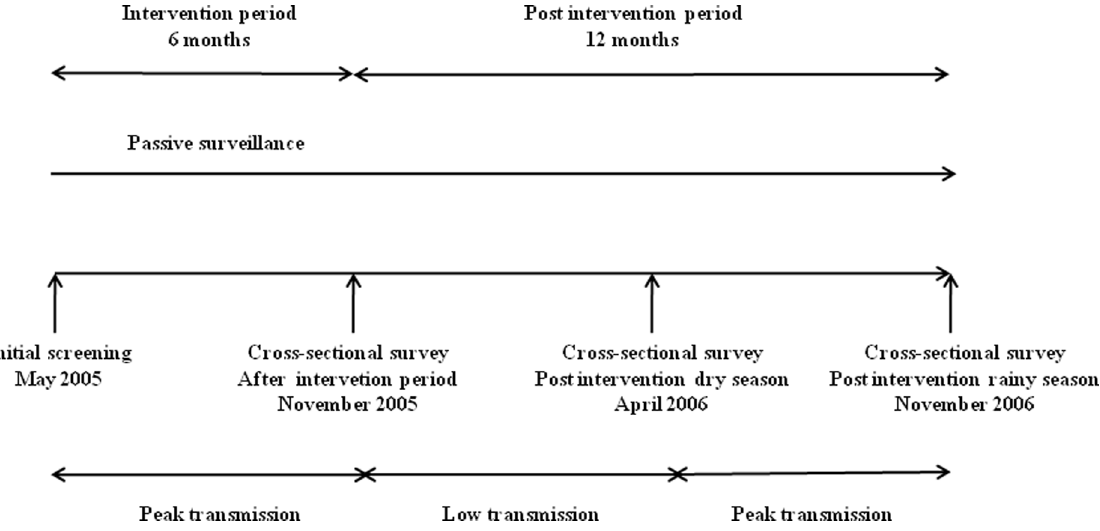
Figure 1. Study outline. Intermittent preventive treatment or placebo was given over a six month-period spanning peak malaria transmission season, followed by a 12-month post interventionsurveillance period. Cross-sectional surveys were performed 1 month (November 2005), 6 months (April2006) and 12 months (November 2006) after the intervention was stopped. Blood films and filter paper samples were collected at these three time points.